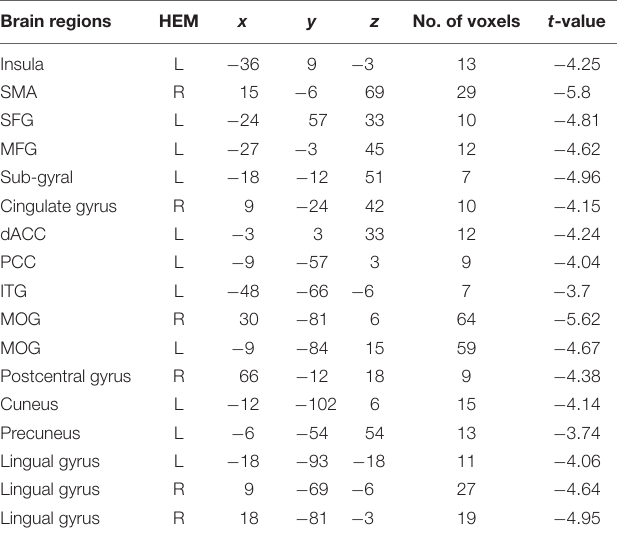
TABLE 7 | Results of PPI analysis of disadvantageous inequity influence